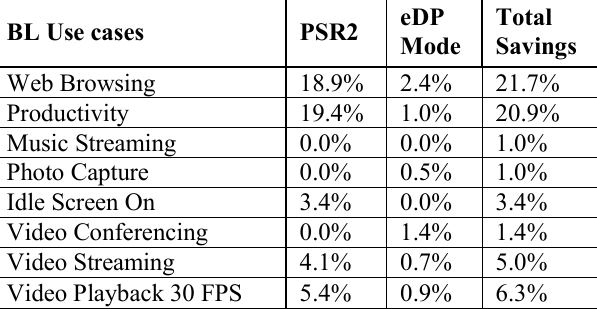
Table 5. Savings from the software